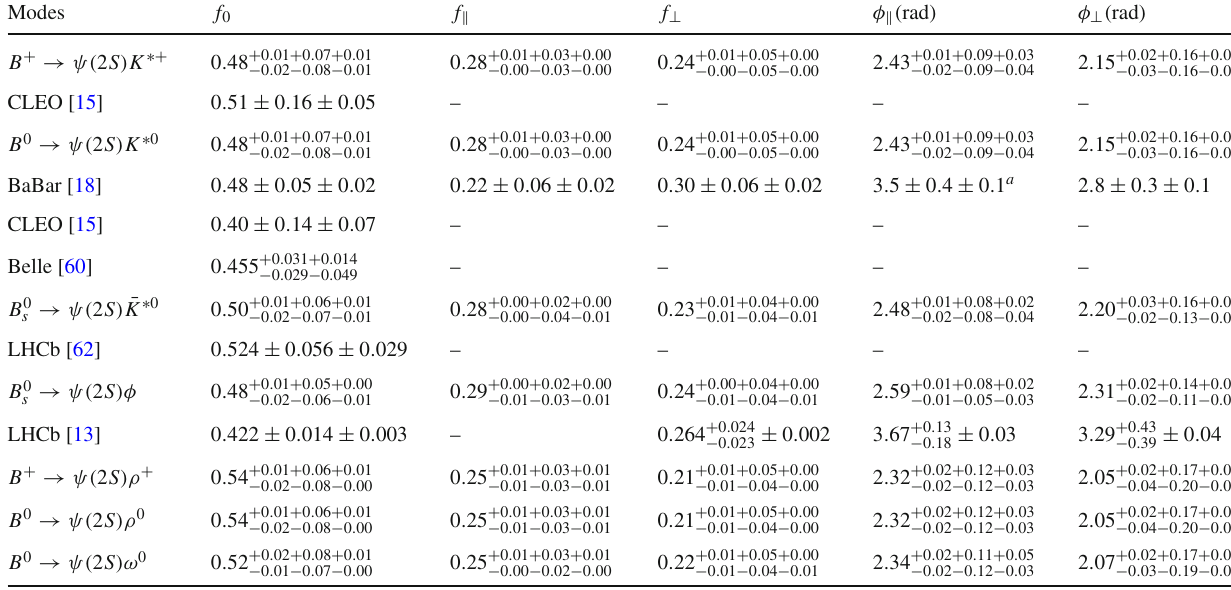
Table 5 The pQCD predictions for the CP-averaged polarization fractions, relative phases in the B → ψ( 2 S ) V decays. The errors correspond to the combined uncertainty in the hadronic parameters, heavy-quark masses and the hard scale